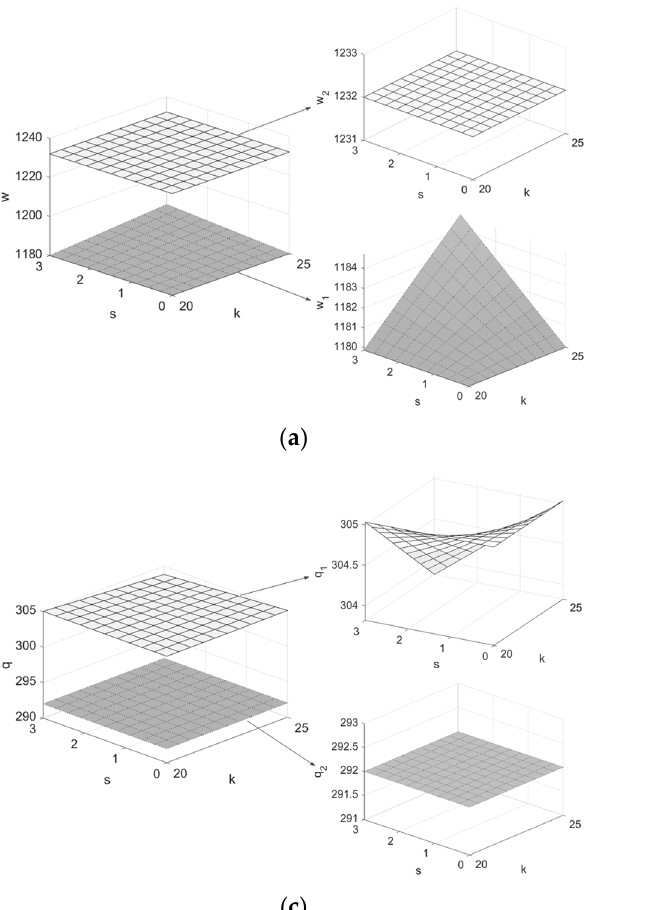
Figure 5. Effects of k and s on decision variables. ( a ) Effects of k and s on w 1 , w 2 ; ( b ) effects of k and s on p 1 , p 2 ; ( c ) effects of k and s on q 1 , q 2 ; ( d ) effects of k and s on π m , π r , π